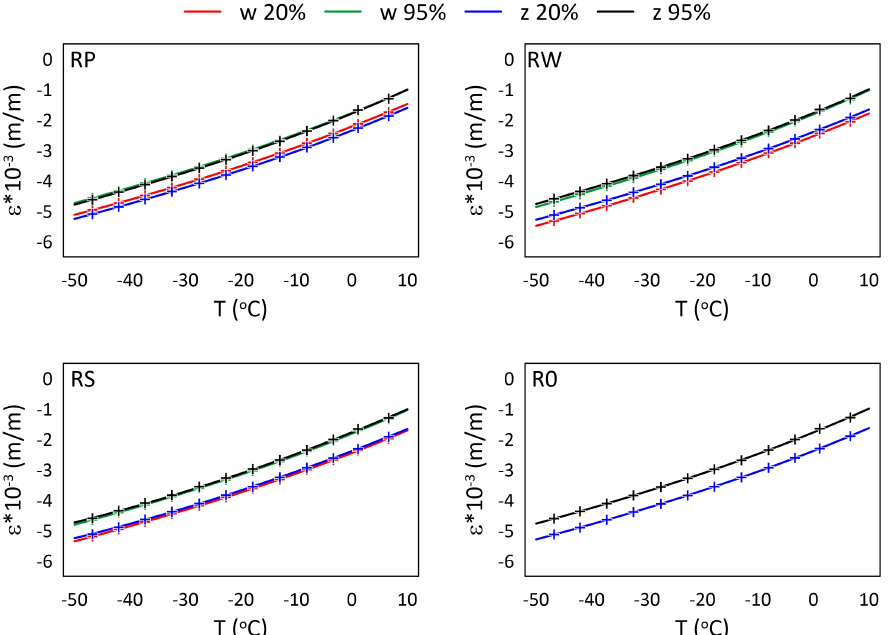
Figure 12. Strain for M3 Crystal samples under sub-zero temperatures and selected RH (20%, 95%) levels; crosses—measured values, continuous